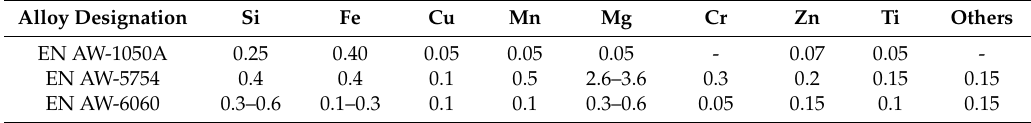
Table 1. Chemical composition of aluminum alloys applied in measurements